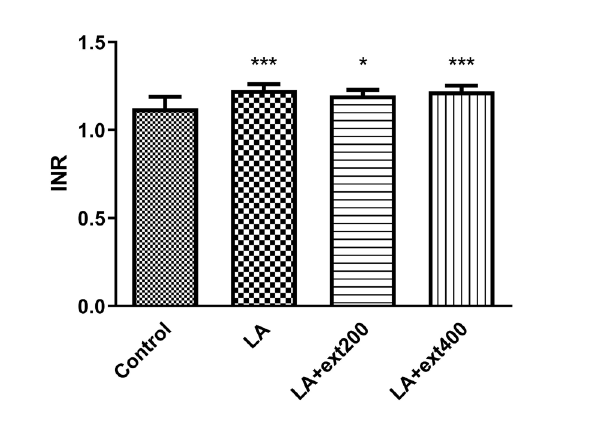
FIGURE 5 - Effect of Rheum ribes extract (ext) on the international normalized ratio in rats treated with lead acetate (LA).